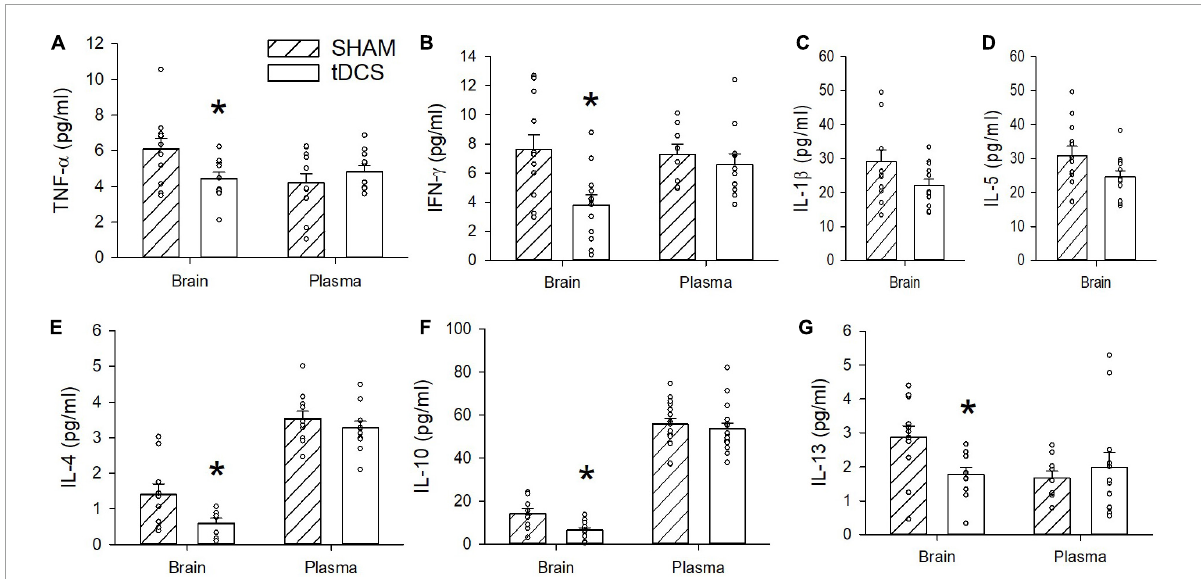
FIGURE2 Effects of transcranial direct current stimulation (tDCS) on brain and plasma cytokine levels. (A) TNF- α was significantly reduced in the brains of rats stimulated with tDCS (* p = 0.03, n = 11, t -test). No significant difference was observed in plasma levels of TNF- α ( p > 0.05). (B) IFN- γ was significantly reduced in the brains of rats stimulated with tDCS (* p = 0.004, n = 12, t -test). No significant difference was observed in plasma levels of IFN- γ ( p > 0.05). (C) A non-significant decrease in IL-1 β level was detected in brains of rats administered tDCS with p = 0.07 ( n = 11 sham, 12 tDCS, t -test). Plasma levels of IL-1 β were below the detection limit. (D) A non-significant decrease in IL-5 was detected in brains of rats administered tDCS with p = 0.08 ( n = 12, t -test). Plasma levels of IL-5 were below the detection limit. (E) IL-4 was significantly reduced in brains of rats stimulated with tDCS (* p = 0.04, n = 10 sham, 7 tDCS, t -test). No significant difference in plasma level of IL-4 (p > 0.05). (F) IL-10 was significantly reduced in brains of rats administered tDCS (* p = 0.005, n = 9 sham, 12 tDCS, t -test). Plasma level of IL-10 was not